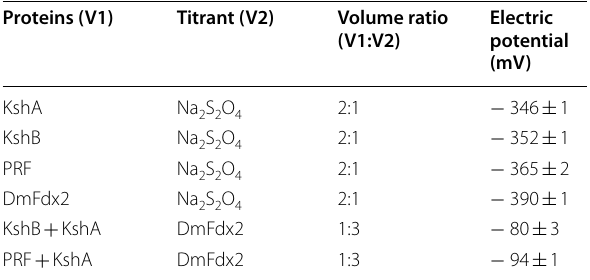
Table 3 Redox potential of reductase and ferredoxin Proteins (V1) Titrant